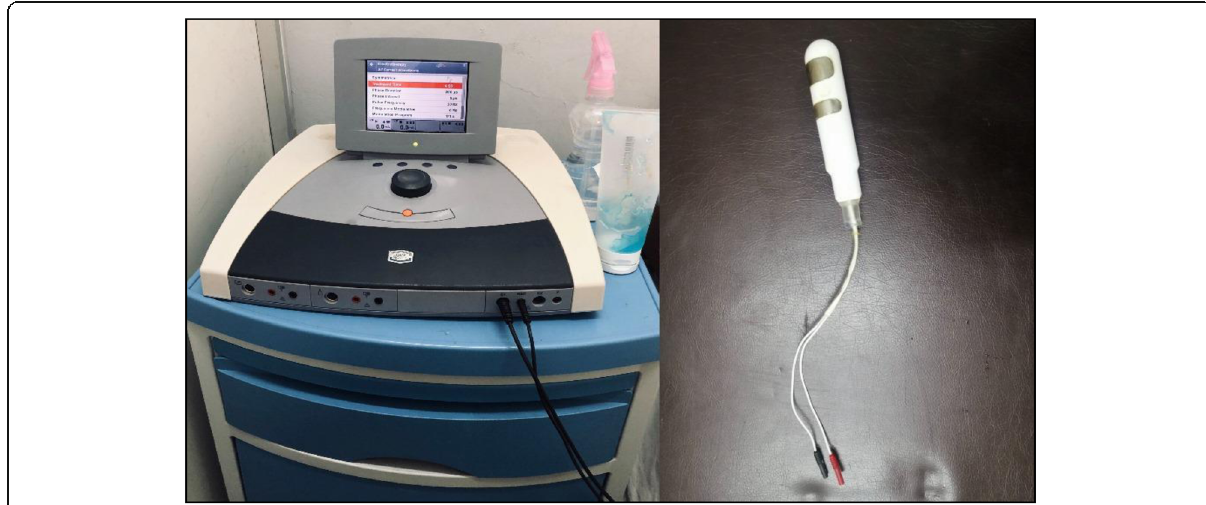
Fig. 3 The biofeedback and electrostimulation device with the transvaginal electrical stimulating probe